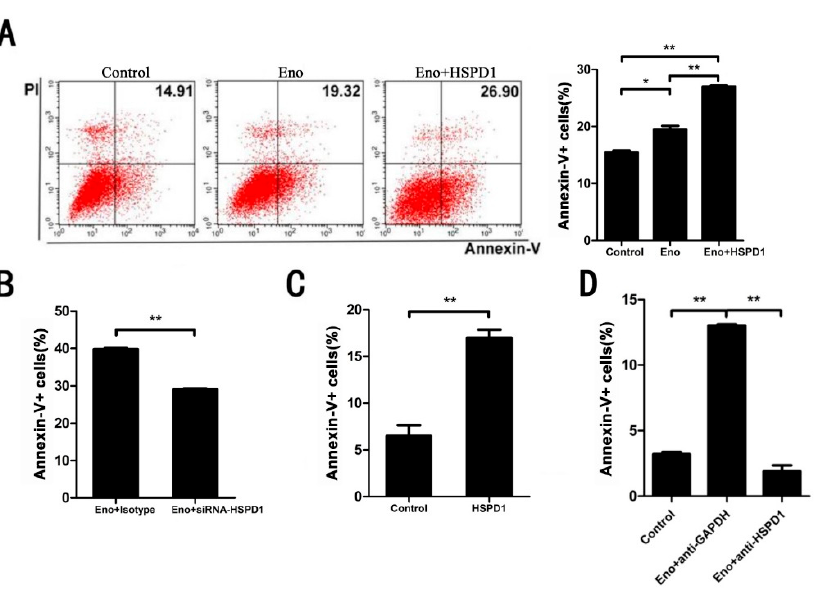
Figure 2. Both intracellular and extracellular HSPD1 can lead to apoptosis. Flow cytometry analysis was performed to detect Eno- or HSPD1-induced apoptosis. ( A ) HSPD1 was overexpressed in 293T cells by transfection of eukaryotic expression plasmid pCMV-3×FLAG-HSPD1, and its effect on Eno-induced apoptosis was analyzed. ( B ) HSPD1 was knocked down in 293T cells by transfection of HSPD1-siRNA, and its effect on Eno-induced apoptosis was analyzed. ( C ) PBMECs were treated with purified HSPD1 protein extracellularly, and the level of apoptosis was determined. ( D ) Anti-HSPD1 IgG prevented extracellular-HSPD1-induced PBMEC apoptosis. The anti-GAPDH group was used as the isotype control. (The numbers in the scatter diagrams represent the percentage of Annexin-V positive cells; the gating strategies are shown in Figure S2; the scatter diagrams of ( B – D ) are shown in Figure S3) (PBMECs: porcine brain microvascular endothelial cells) (*, p < 0.05; **, p <